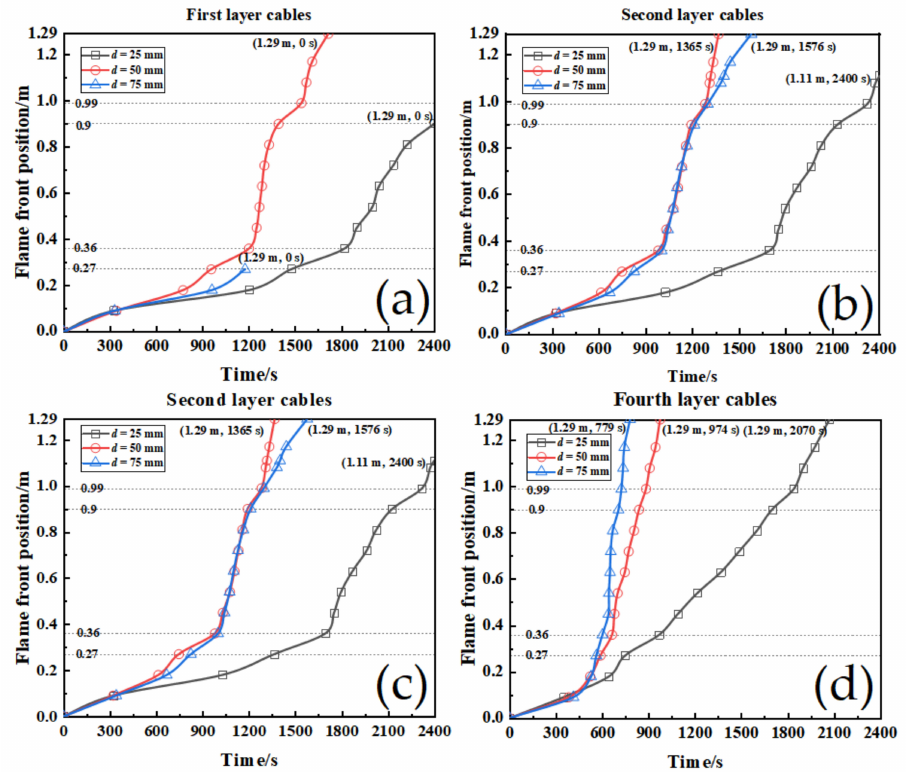
Figure 11. The flame spread rate at different cable tray spacings: ( a ) First layer of cables; ( b ) Second layer of cables; ( c ) Third layer of cables; ( d ) Fourth layer of